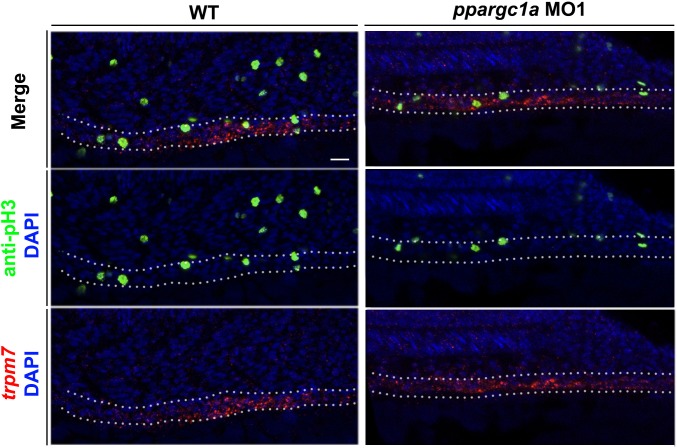
Confocal image split channels of trpm7 and anti-pH3 in WT and ppargc1a deficient 20 ss zebrafish.trpm7 (red) with DAPI (blue) on bottom, anti-pH3 (green) with DAPI (blue) middle, and merge on top. Scale bar = 30 μm.